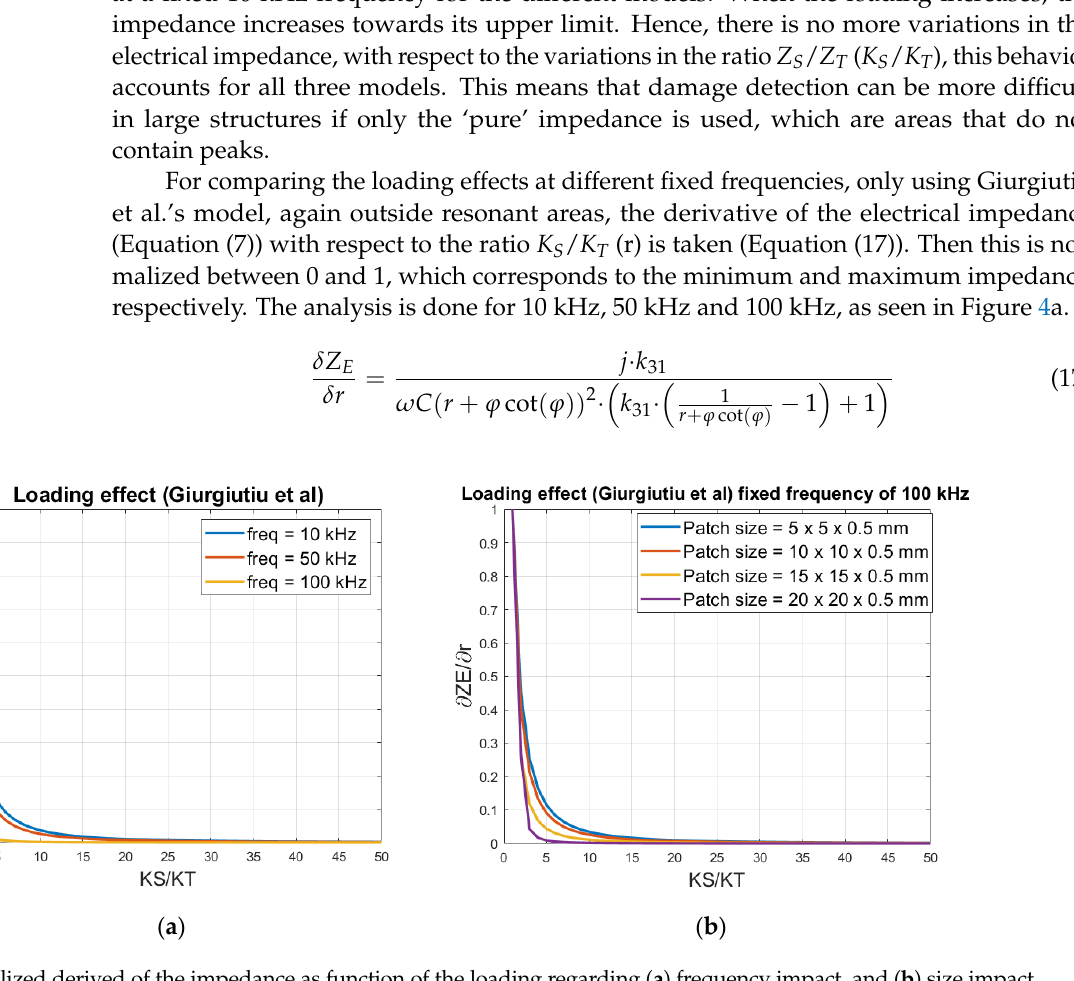
Figure 3. Normalized impedance values as function of the loading ZS / ZT ( KS / KT ) with all three models at 10 kHz.